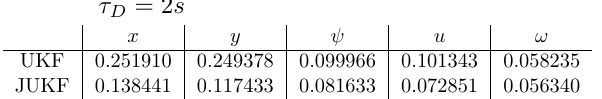
Table 3: RMS errors of the simulation Test 3, τ C = 3 s